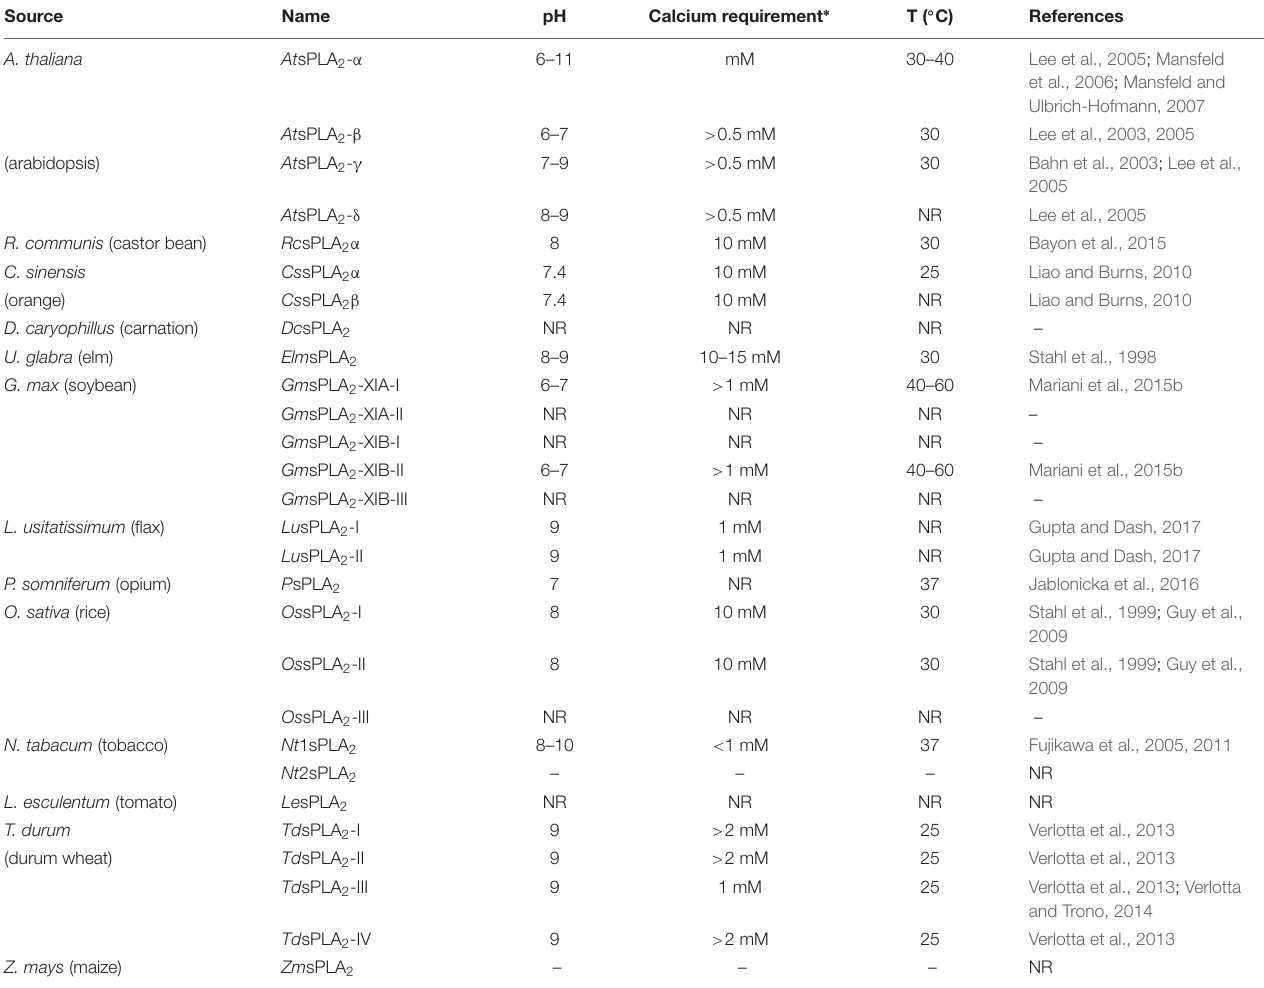
TABLE 7 | Optimum requirements deduced for catalytic activity of the different sPLA 2 s found in plants.